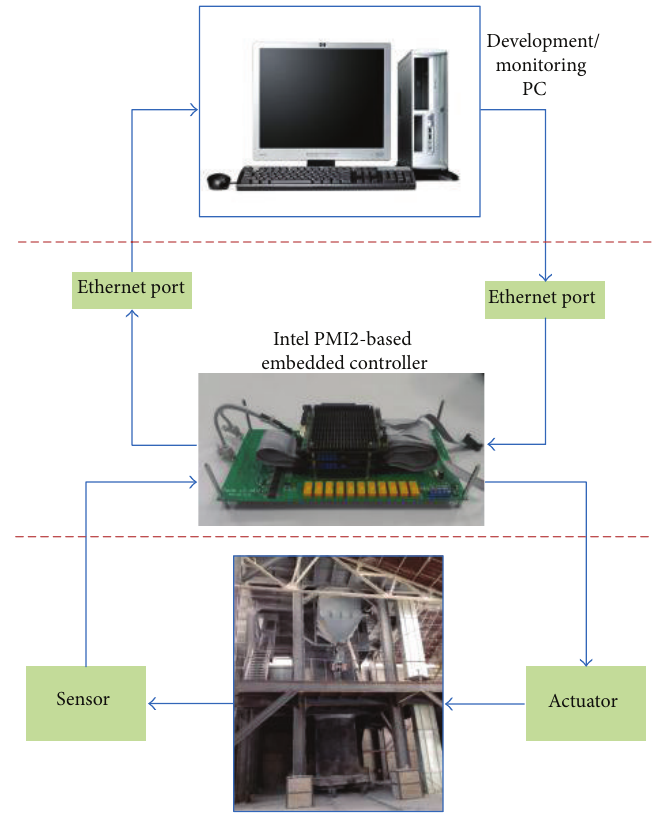
Figure 2: System architecture of arm-type electro-fused magnesia furnace.